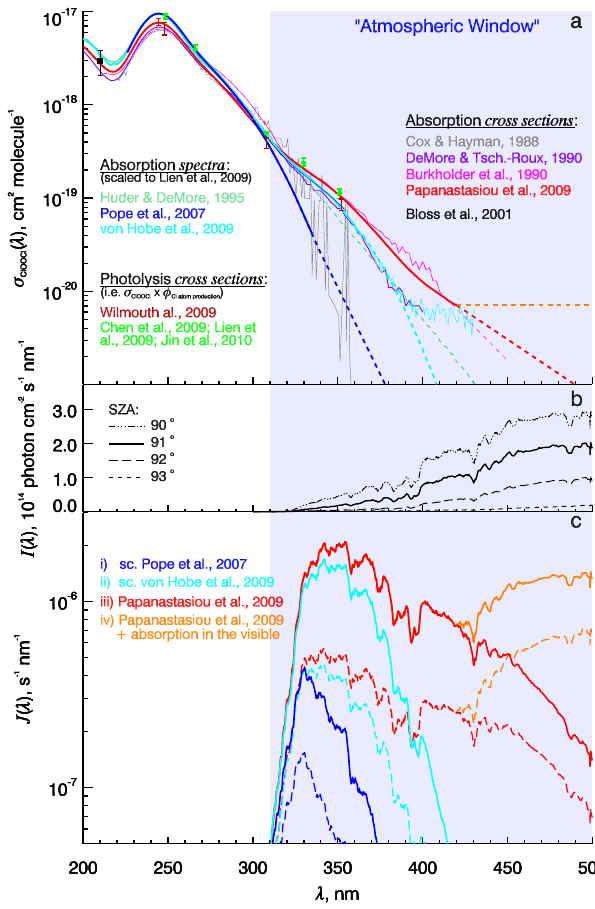
Fig. 1. The upper panel presents a comparison of UV/Vis absorp- tion spectra, absorption cross sections and photolysis cross sections of ClOOCl from various studies. The dashed extensions show the exponential extrapolation of chosen spectra in the actinic region. Spectra i–iv (cf. Sect. 2.4) used in this study are shown with thicker lines, with the artificial spectrum for examination of the hypothesis of a ClOOCl absorption band in the visible represented by a dashed orange line. The middle panel shows spectral actinic flux I(λ) cal- culated for four solar zenith angles. The photolysis rate constants estimated for absorption cross sections and spectra i–iv and solar zenith angle (SZA) equal 91 ◦ (solid line) and 92 ◦ (dashed line) are shown in panel (c)